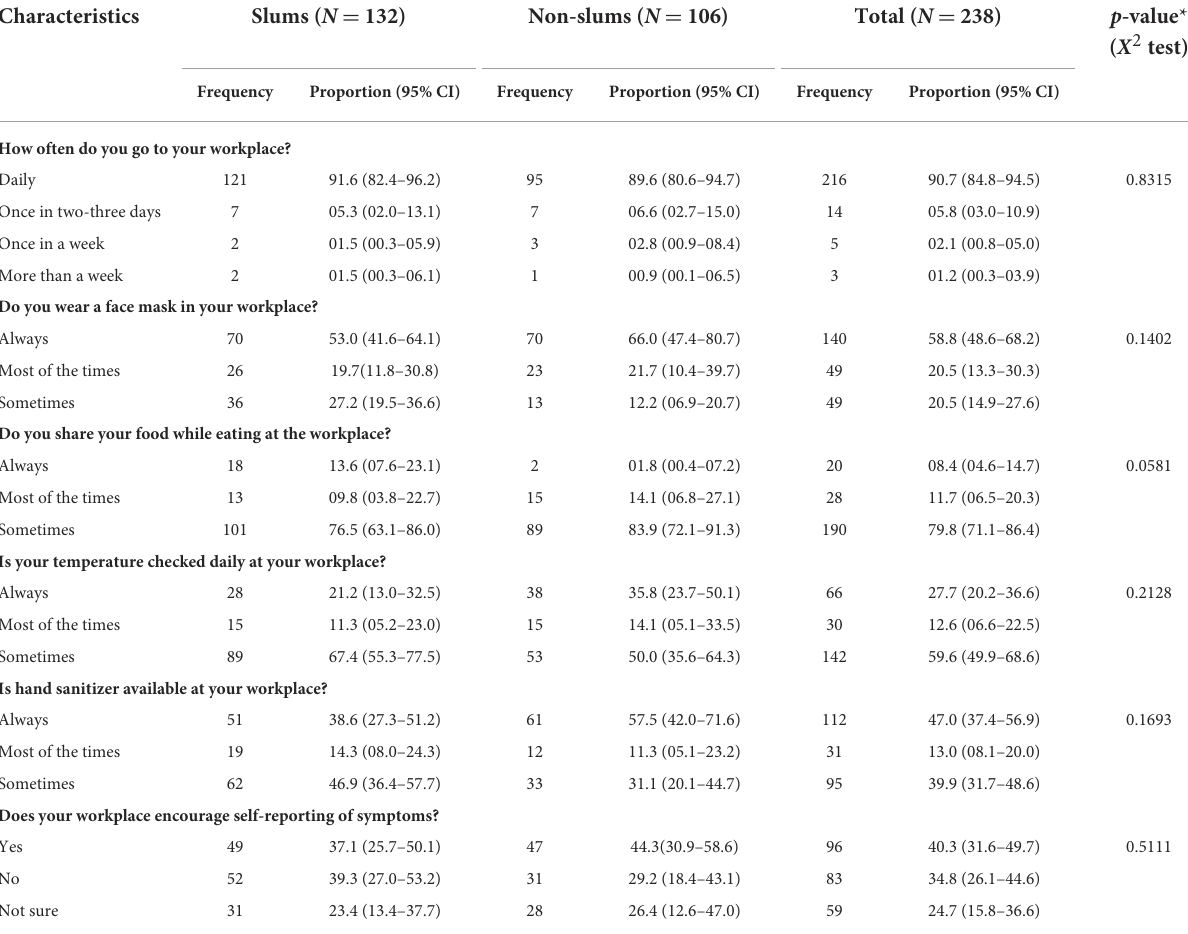
TABLE 5 Practice of Mask use at Workplaces among the slum and non-slum population, Greater Chennai Corporation, India, March 2021 ( N = 238).